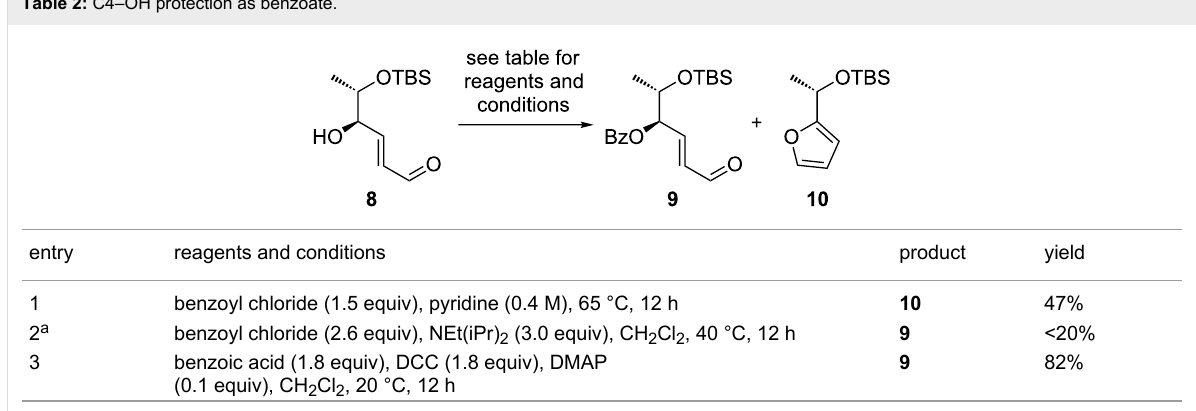
Table 2: C4–OH protection as